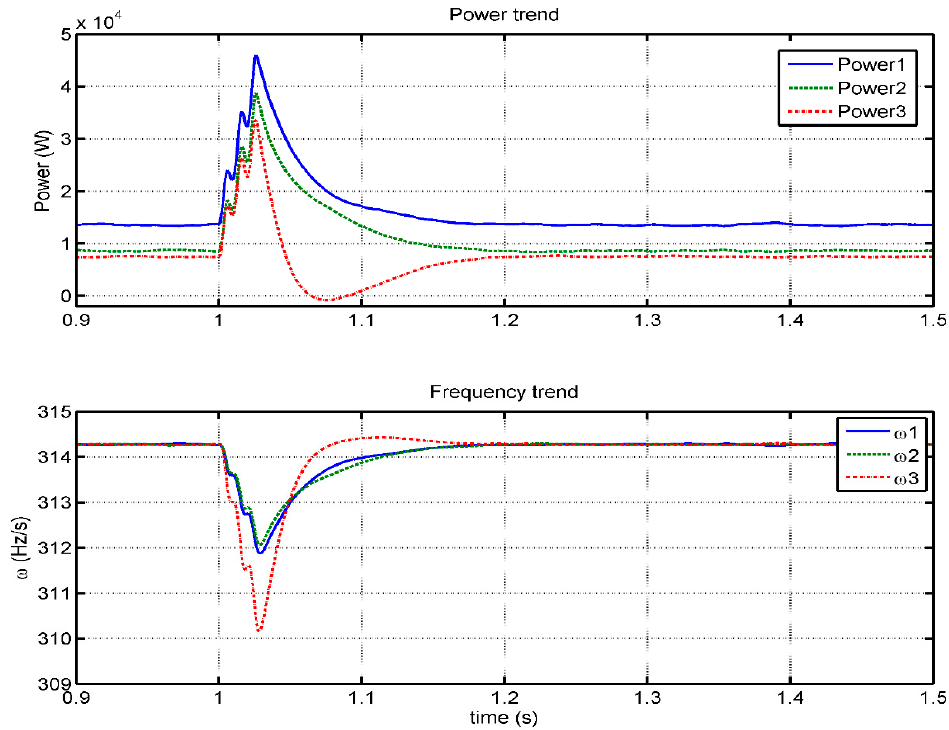
Figure 22. Fault Analysis Case IV.